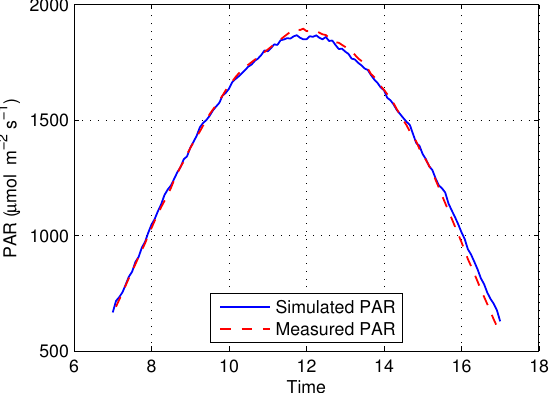
Figure 9. The simulated PAR and measured above-canopy PAR on San Joaquin Experimental Range